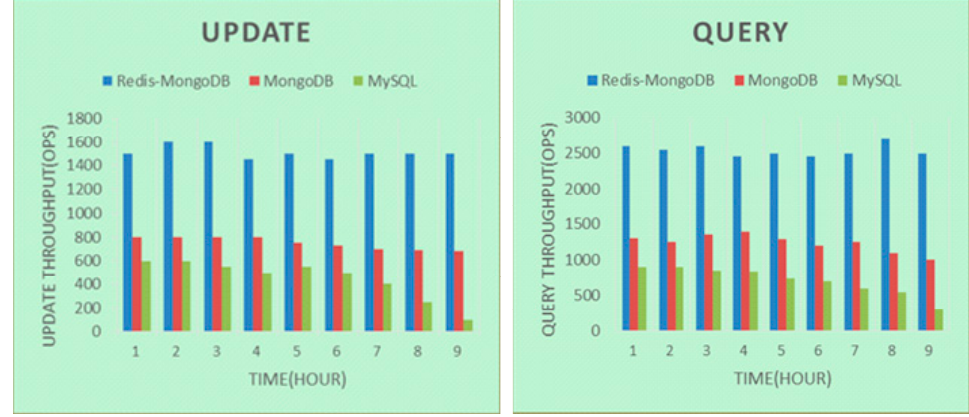
Figure 12. The access performance of the GeoVideo database.